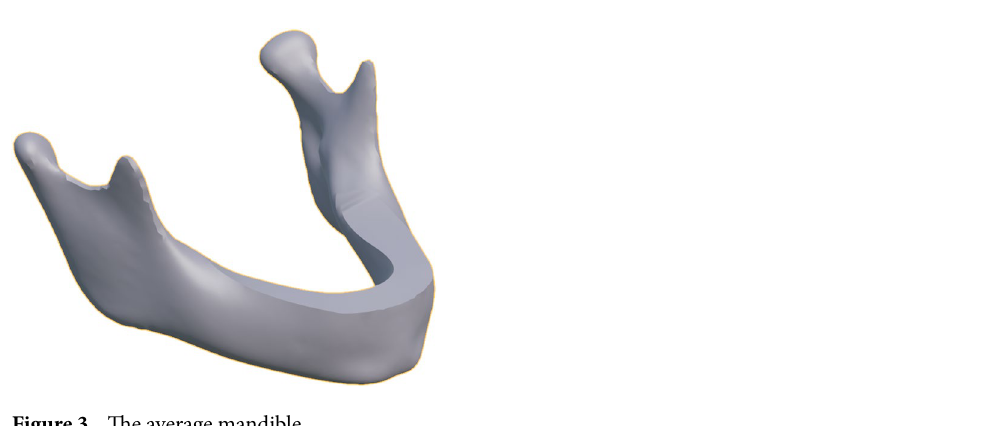
Figure 3. The average